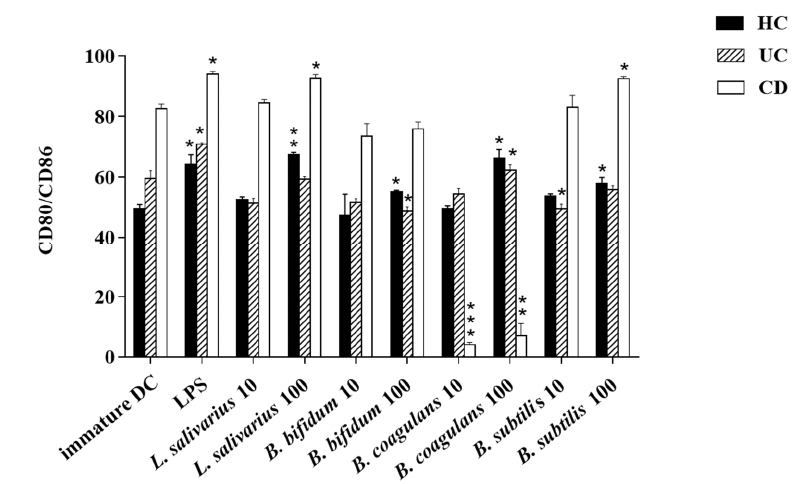
Figure 3. Bar graph chart representing the expression of CD80 / CD86 in enriched DC population with the respective probiotic strains. HC: healthy controls, UC: ulcerative colitis, CD: Crohn’s disease. * p < 0.05, ** p < 0.01, and *** p < 0.001.